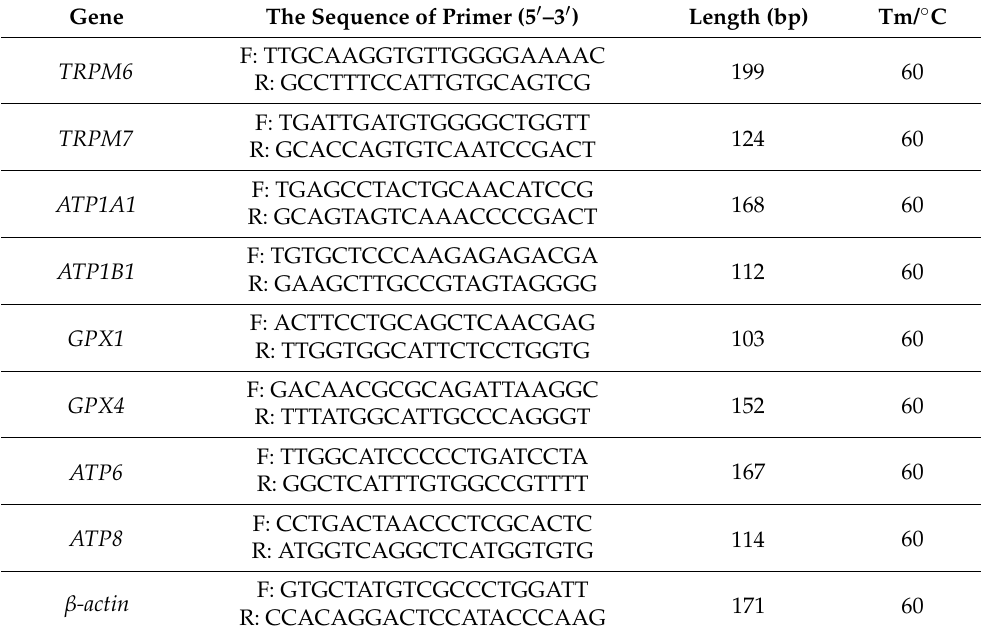
Table 2. Primer sequences used for quantitative real-time